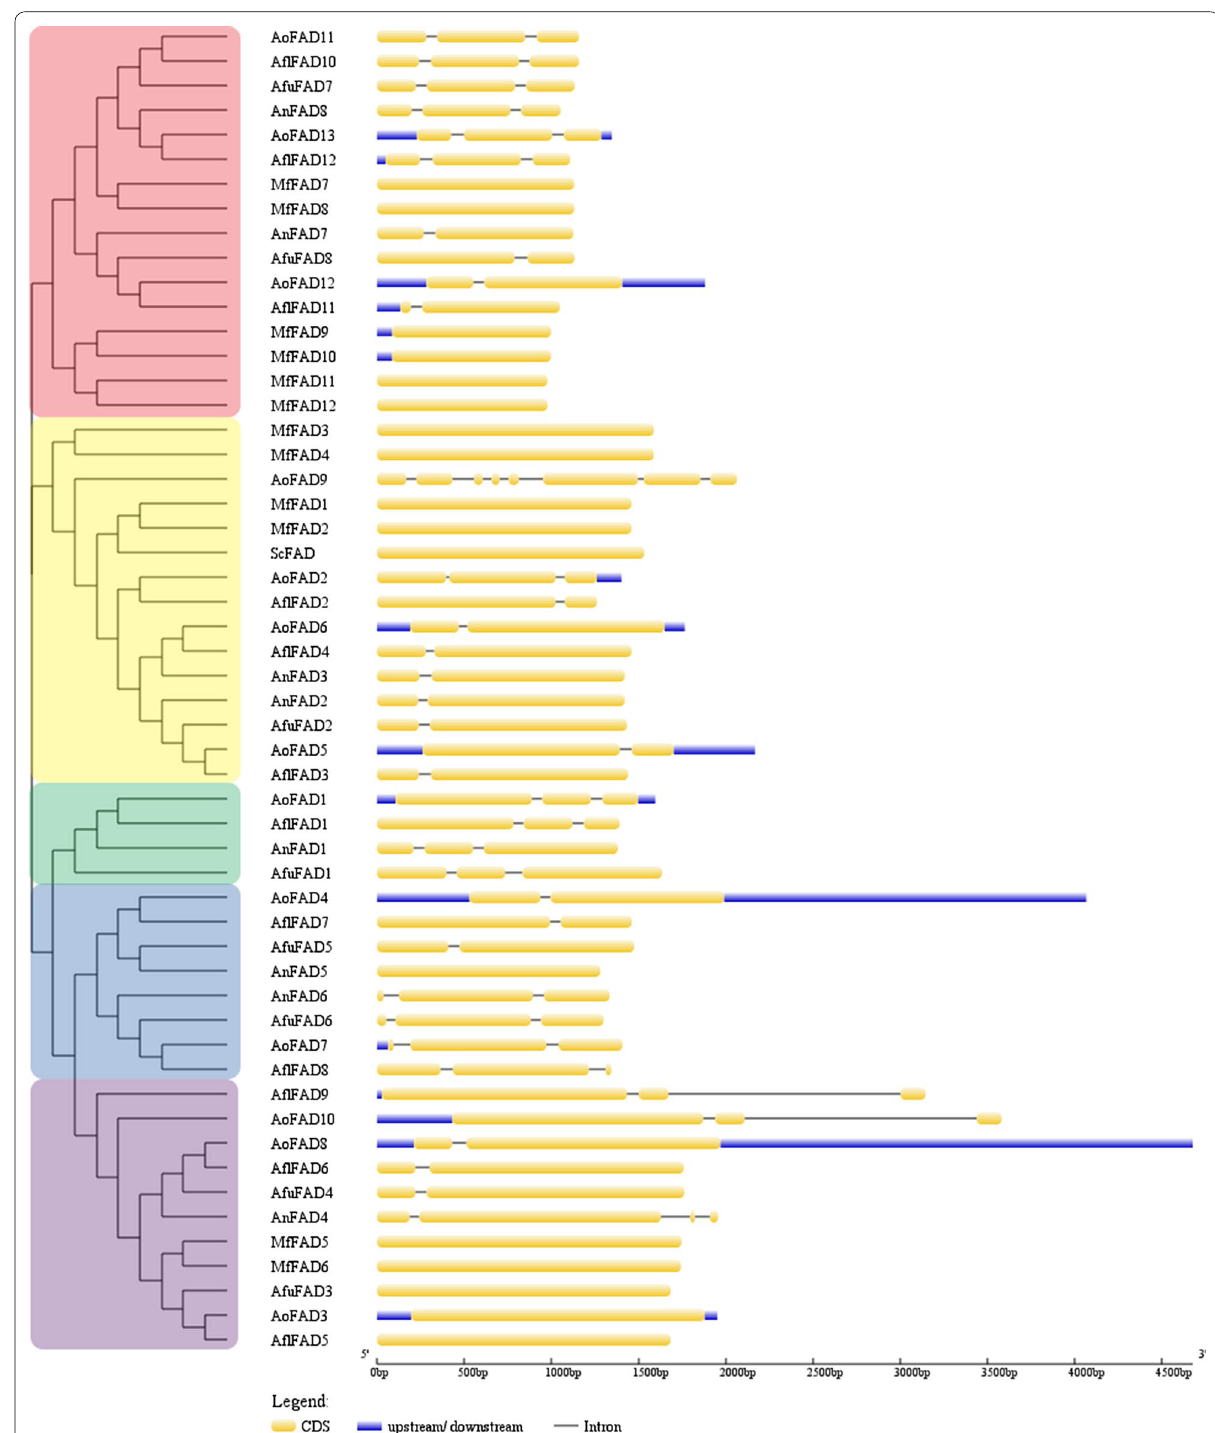
Fig. 3 The gene structure analysis of fatty acid desaturases proteins based on their phylogentic